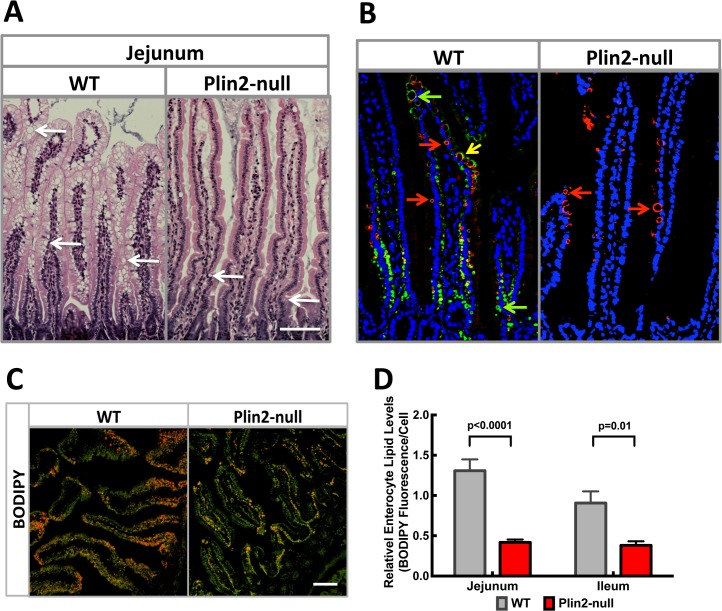
Effects of HF diet feeding on intestinal lipid properties.(A) Representative H&E stained jejunal sections from HF fed WT and Plin2-null mice. Note the apparent greater abundance of CLD (arrows) in intestinal villi from WT mice compared to Plin2-null mice. Scale bar = 100 μm. (B) Representative immunofluorescence images of jejunal sections from fasted and HF fed WT and Plin2-null mice stained with guinea pig anti-Plin2 (green) and rabbit anti-Plin3 (red) showing Plin2- (green arrows) and Plin3- (red arrows) coated CLD. Yellow arrow indicates CLD coated with Plin2 and Plin3. (C) BODIPY stained CLD (Red) and Alexafluor-WGA (green) stained intestinal villi surfaces from fasted and fed WT and Plin2-null mice. Scale bar = 100 μm. (D) Relative enterocyte lipid levels. Values are mean BODIPY fluorescence area/cell ± SEM from 8–10 200X sections from the jejunal and ileal regions of each mouse. Four animals per group were analyzed. P-values were determined using the unpaired t-test (Prism 6, GraphPad Prism).